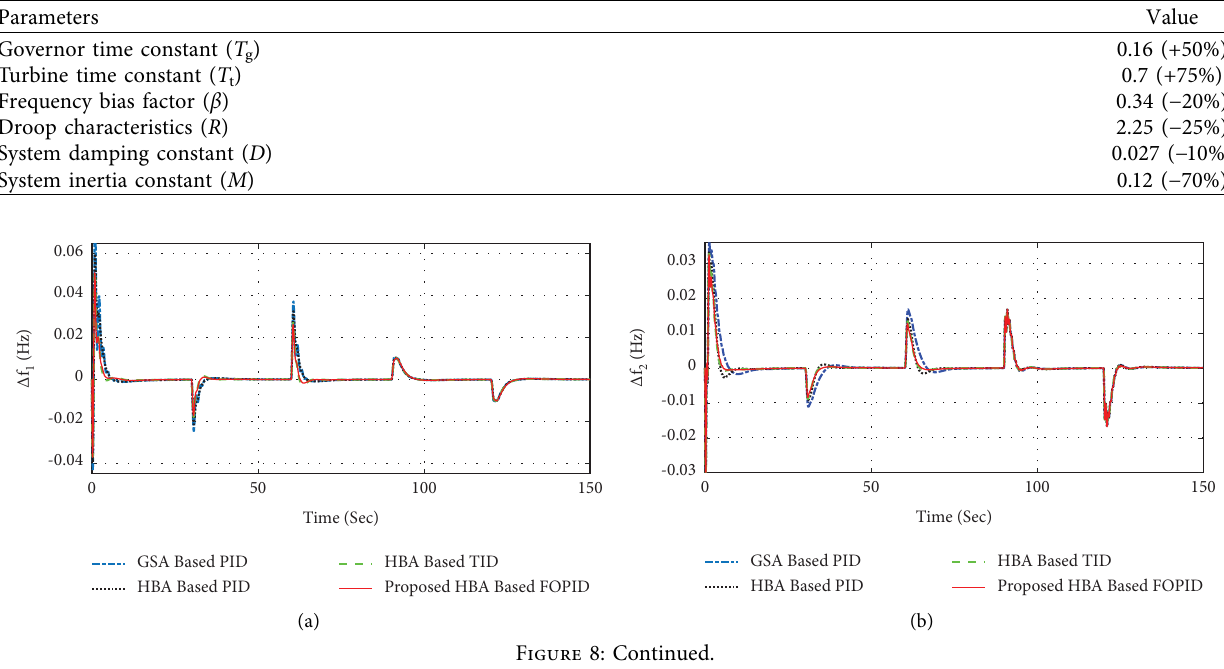
Figure 7: (a–c) System response for condition 3: (a) A Table 4: Sensitivity analysis parameters for the hybrid power